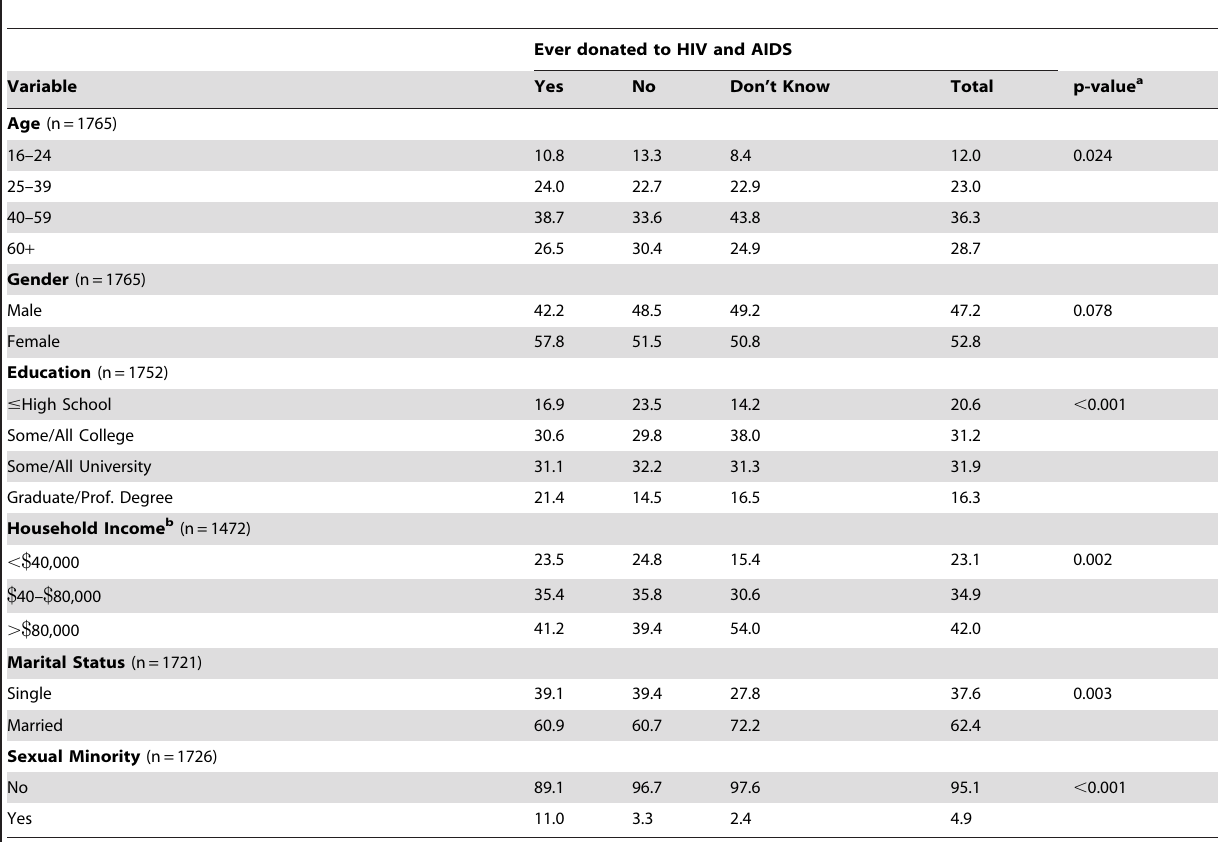
Table 3. Bivariate Socio-Demographic Associations with Ever Donating to HIV and AIDS among Participants who Donated to HIV and AIDS in the past 12 Months (n= 1765, Weighted